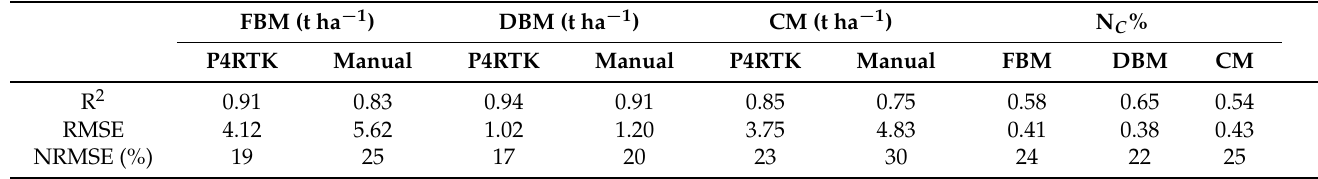
Table 3. Regression performance results for the estimation models for fresh (FBM) and dry biomass (DBM), crop moisture (CM) and N concentration (N C ) against UAV-based and manually measured CH data. ( p < 0.001 for all regression